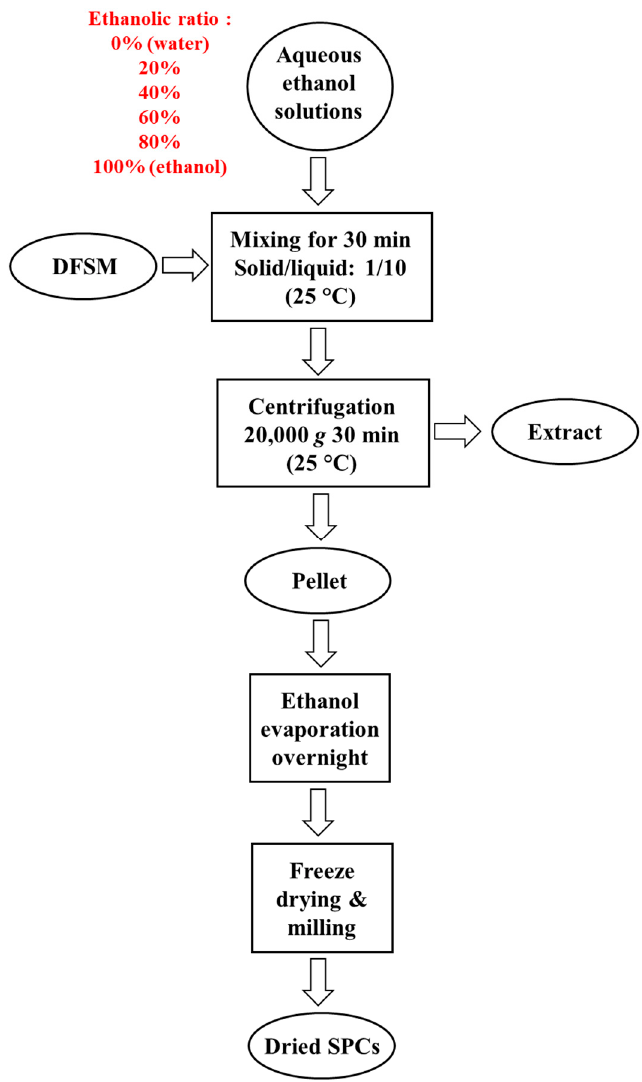
Figure 1. Scheme for the aqueous ethanol washing process. DFSM was mixed with aqueous ethanol solution in a solid/liquid ratio of 1:10 ( w / v